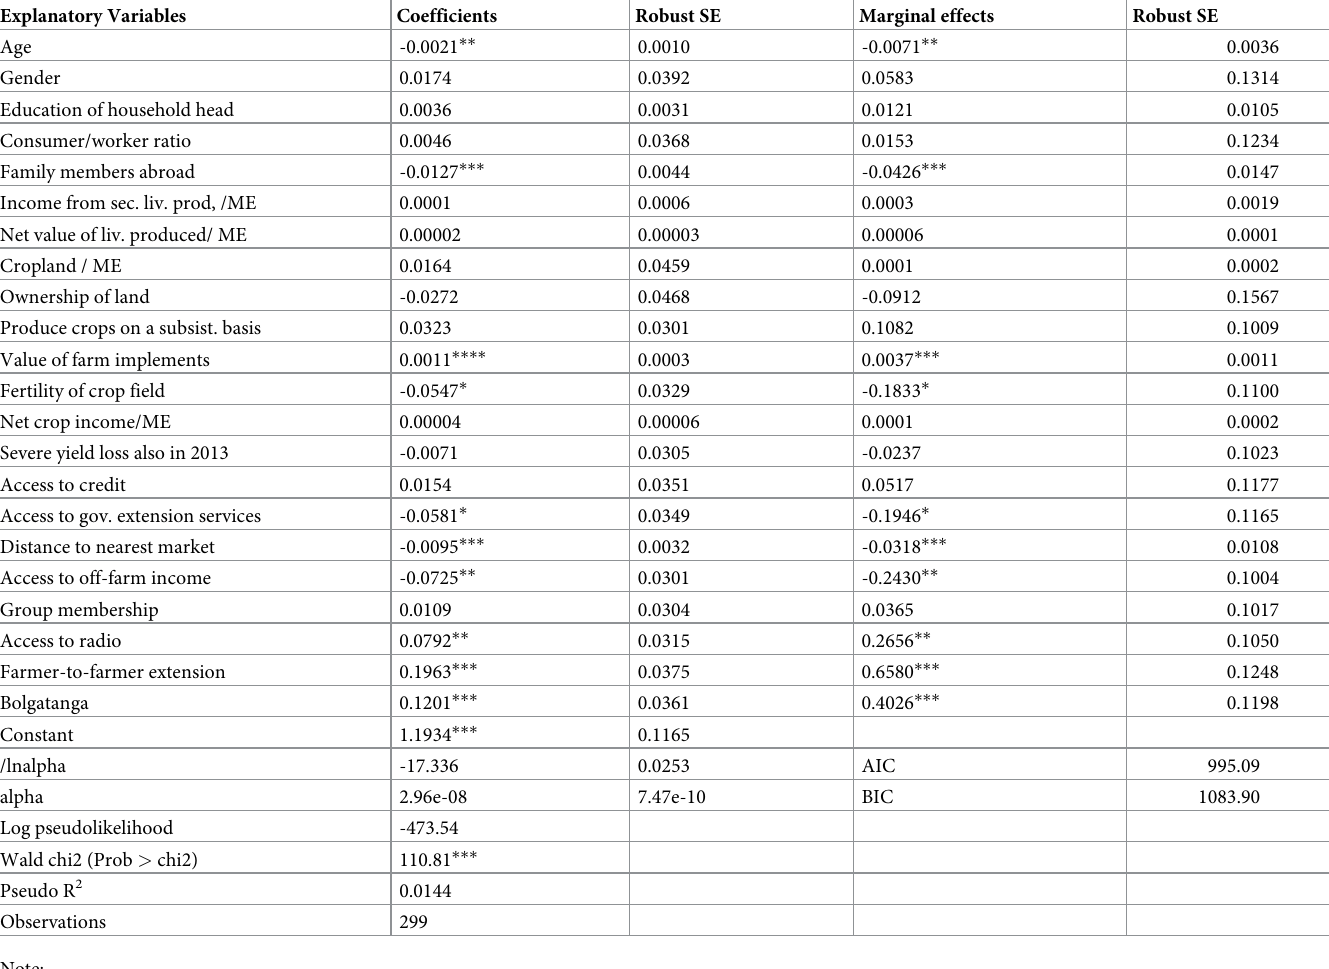
Table 4. Zero-truncated negative binomial regression estimates on intensity of coping